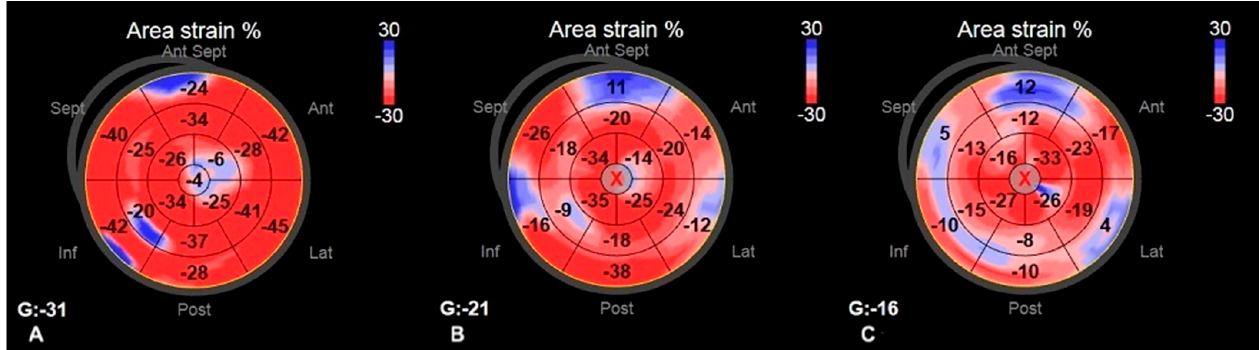
Figure 4. The example of 3D LV area strain measurements—the bull eye representation of a healthy person ( A ); HCM patient without FA diagnosis ( B ); and HCM patient with FA diagnosis ( C ).